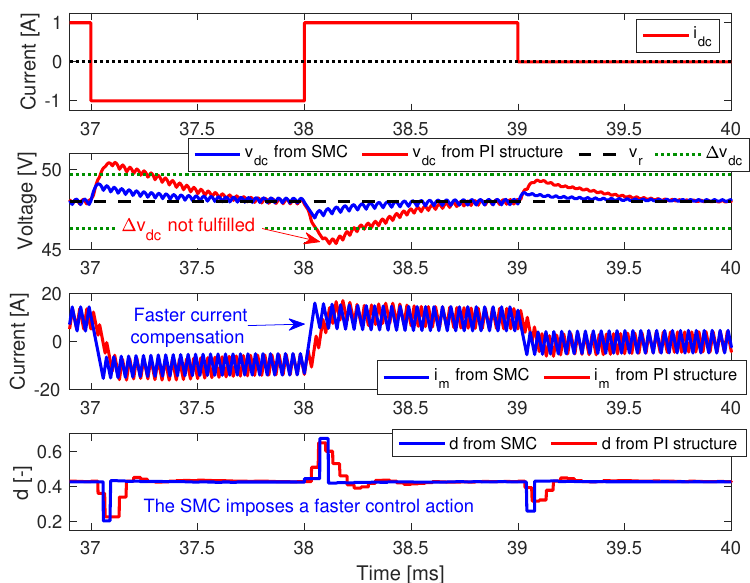
Figure 16. Comparison between the proposed SMC and a classical PI